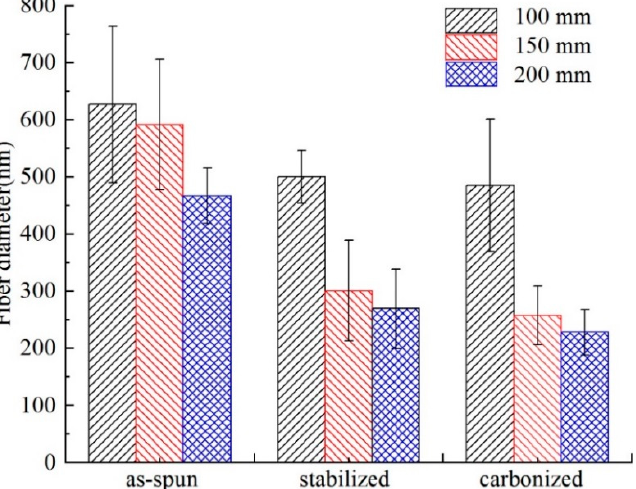
Figure 14. Comparison of the fiber diameter of different receiving distance at different processing stages: ( a ) 100 mm; ( b ) 150 mm; ( c ) 200 mm.